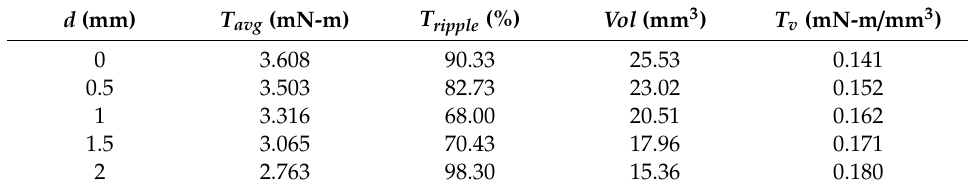
Figure 4. Motor designs with various interpole iron widths. Table 2. Motor characteristics with interpole iron widths of 0, 0.5, 1, 1.5, and 2 mm.